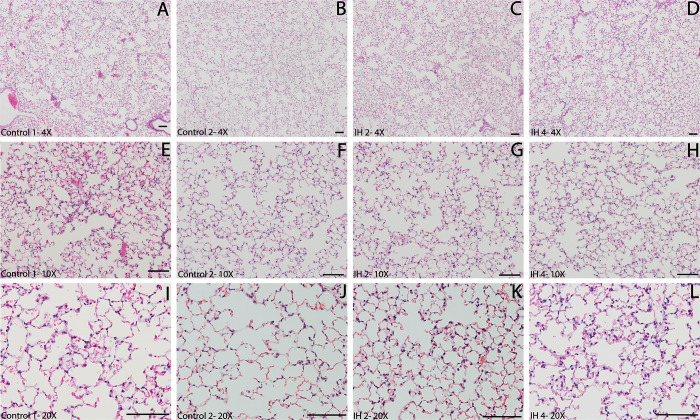
Hematoxylin and eosin (HE)-stained sections of whole lung from mice exposed to IH vs controls do not reveal comprehensive histologic changes.Two representative IH and two control mice with HE-stained sections were shown at 4× (A–D), 10× (E–H), and 20× (I–L) magnification. The scale bars all correlate to 100 µm width.